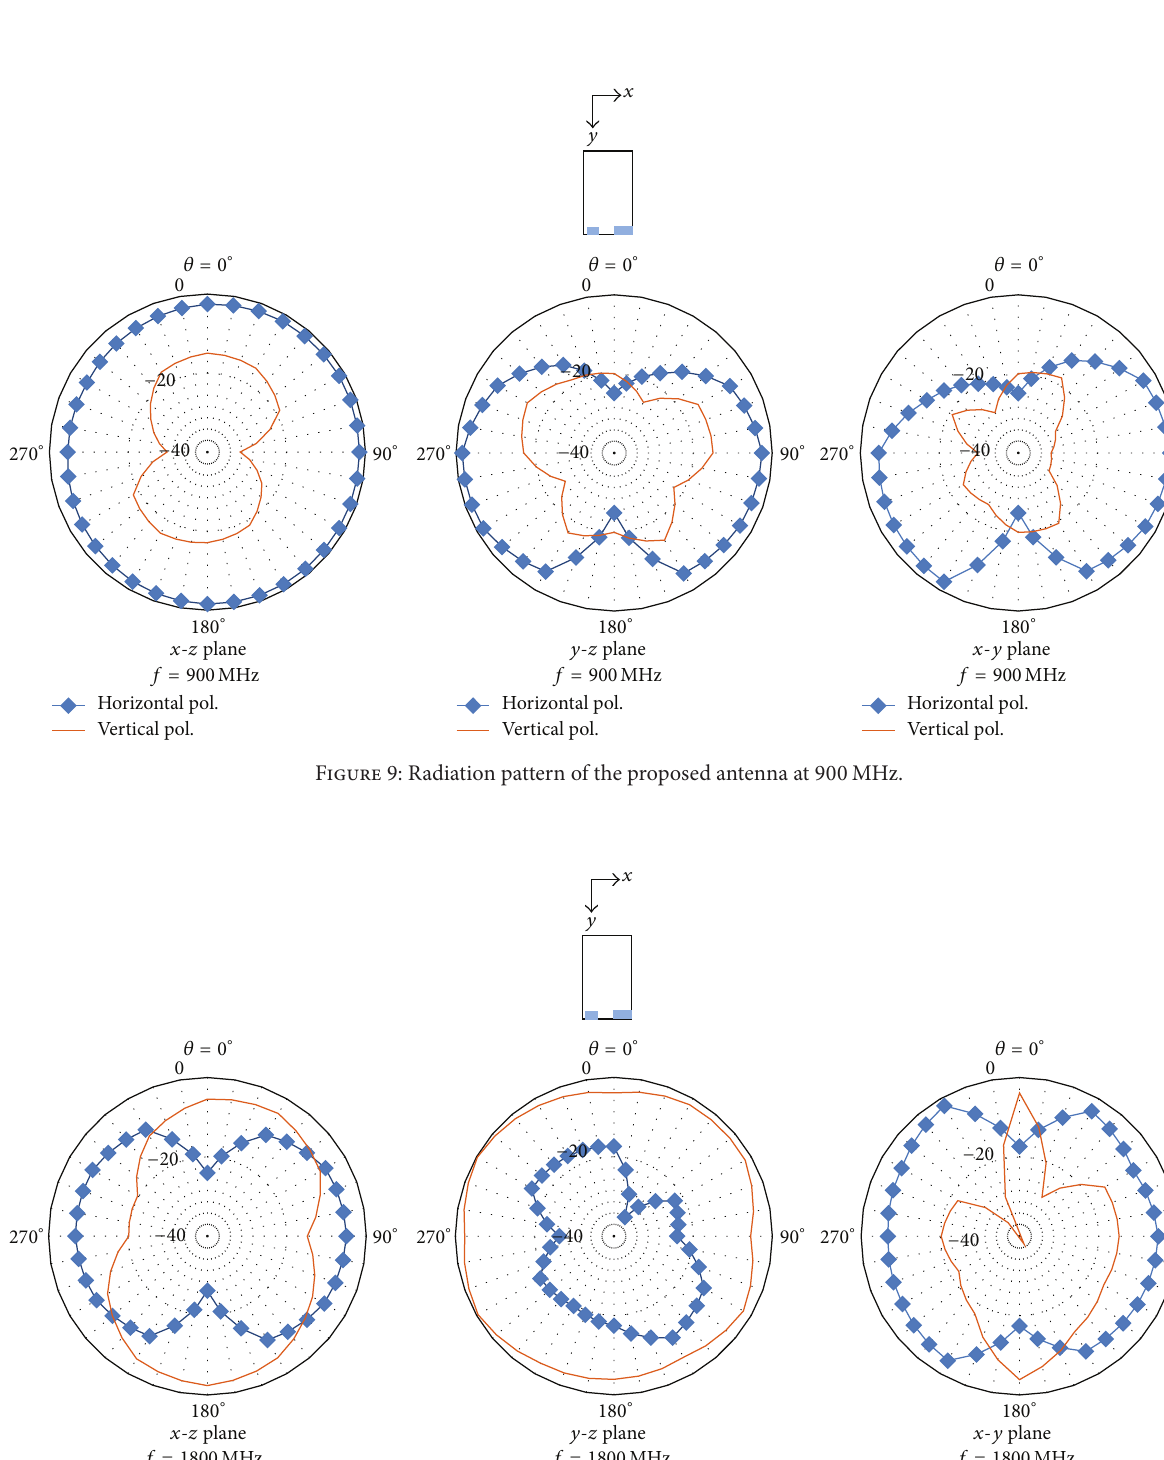
Figure 10: Radiation pattern of the proposed antenna at 1800